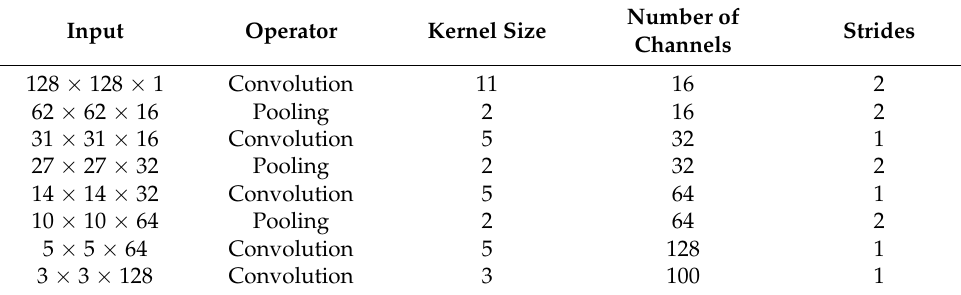
Table 1. The architecture of the LightNet used in our